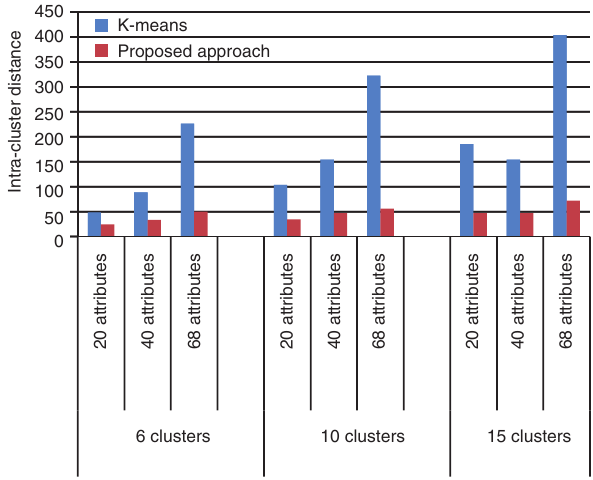
Figure 4: Comparison of Obtained Results for Uscensus Dataset Based on Intra-cluster Distance.